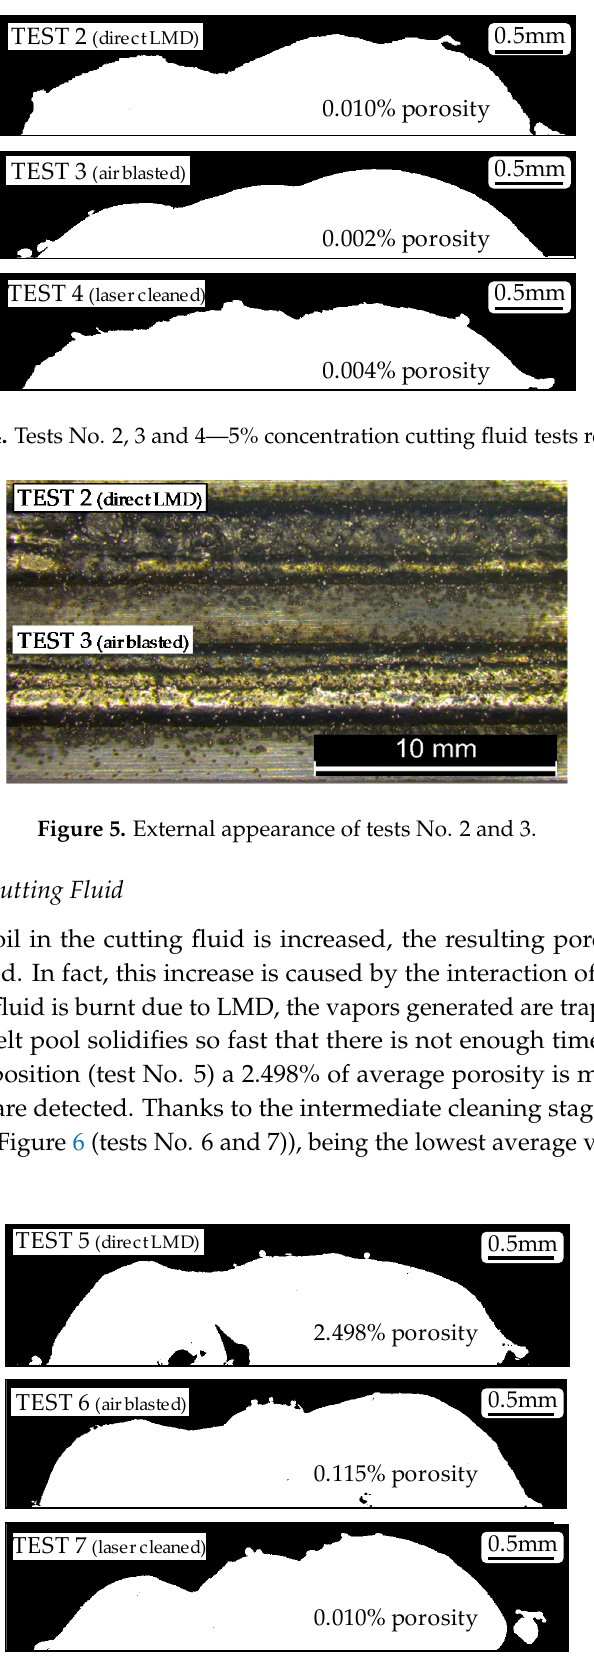
Figure 6. Tests No. 5, 6 and 7—10% concentration cutting fluid tests results.